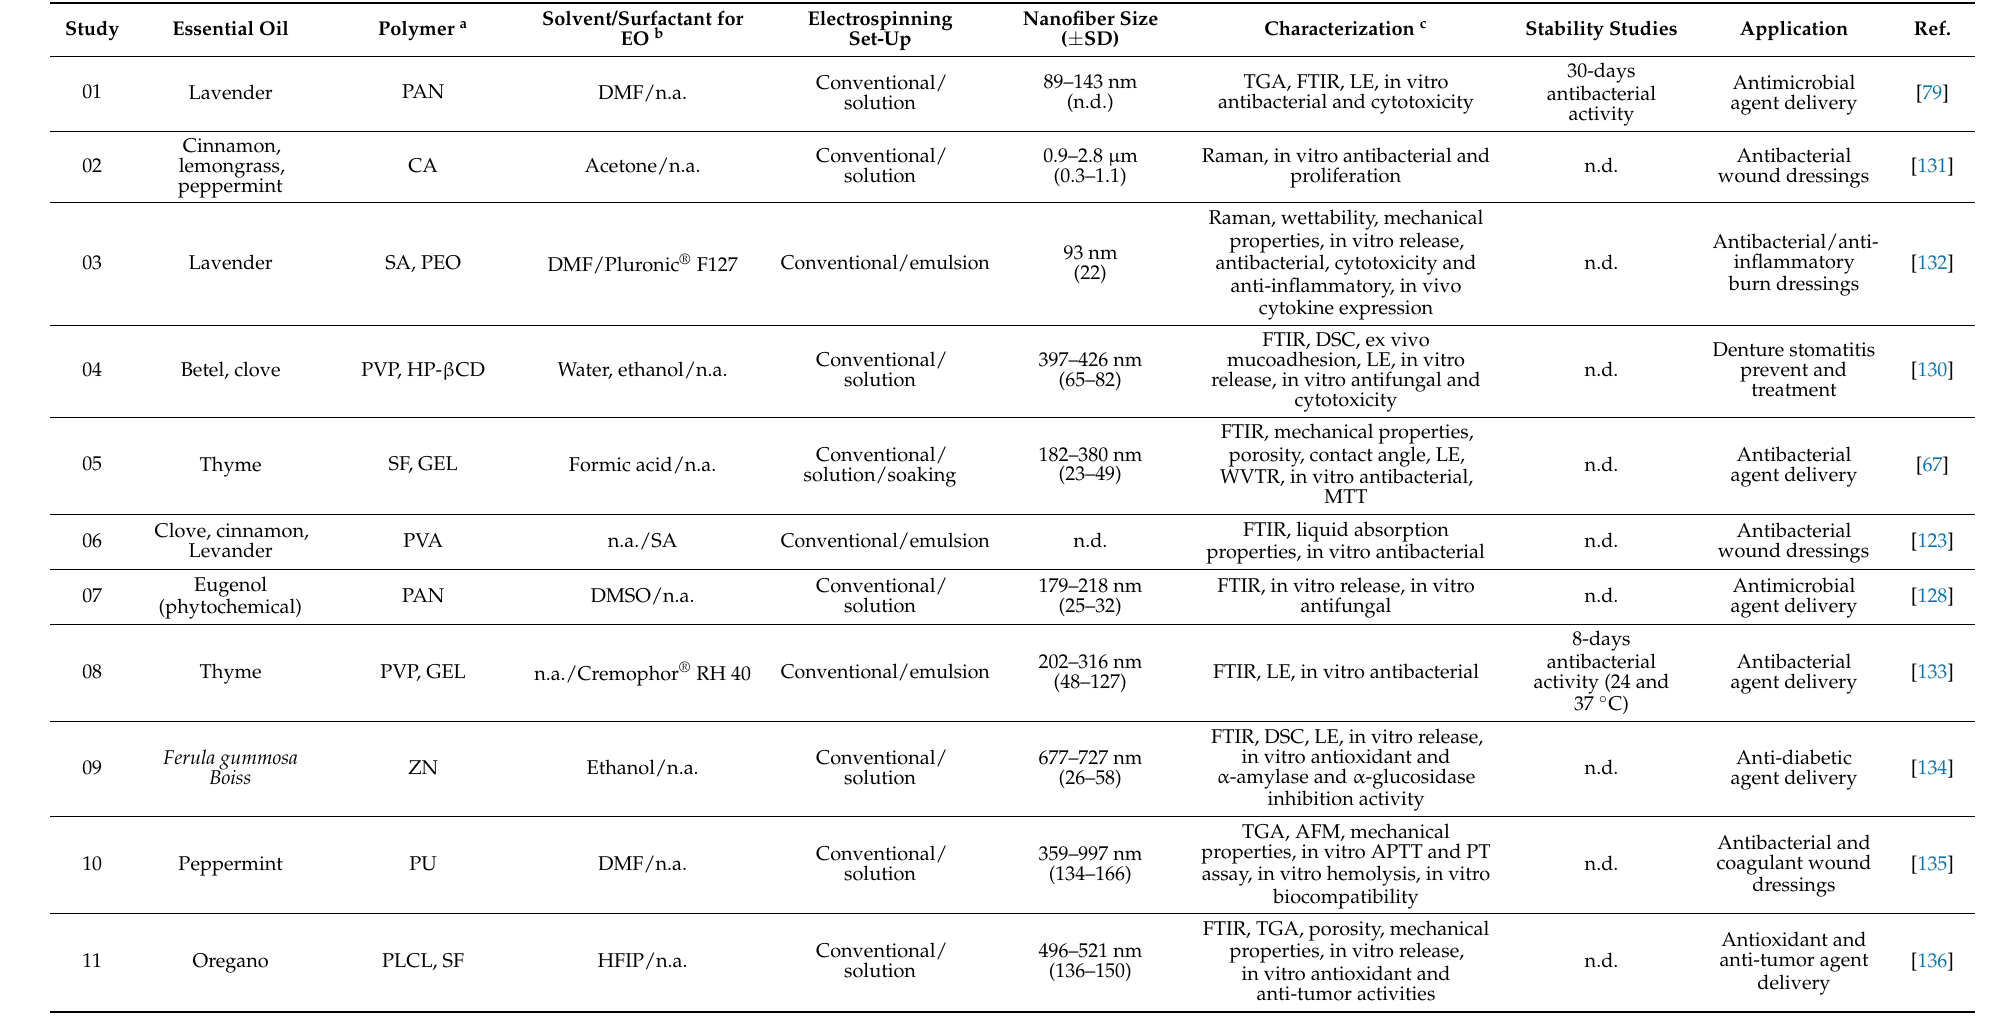
Table 1. Studies on essential oil—loaded nanofibers (EONFs) intended for pharmaceutical or biomedical